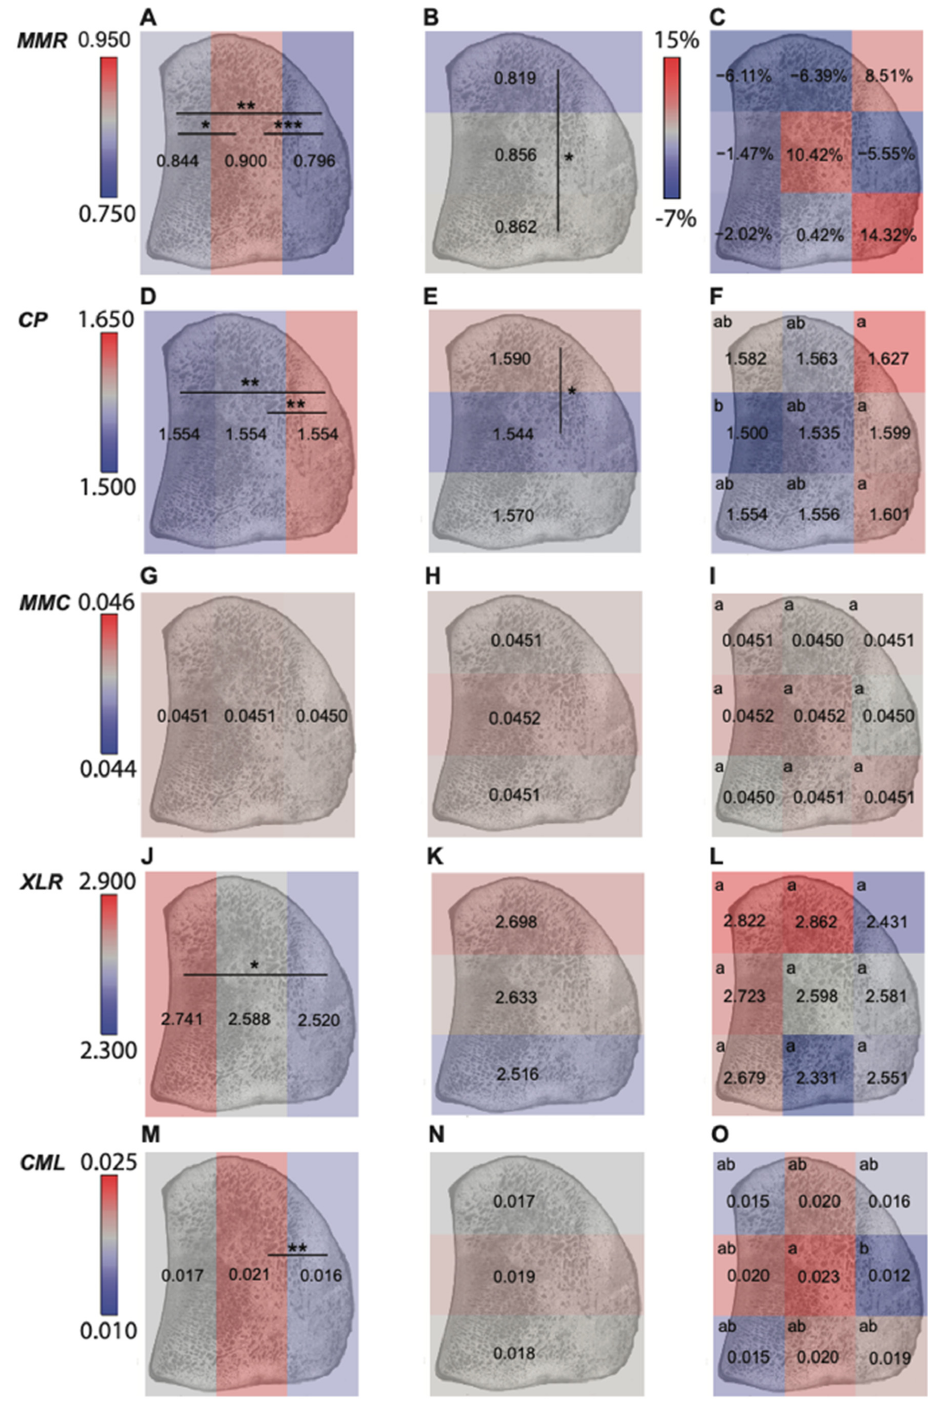
Figure 4. Regional comparison results within a mid-sagittal section of the proximal sesamoid bone of ( A ) mineral:matrix ratio across 3 dorsal-palmar regions; ( B ) mineral:matrix ratio across 3 proximal- distal regions; ( C ) mineral:matrix ratio across 9 anatomic sub-regions; ( D ) carbonate: phosphate ra- tio across 3 dorsal-palmar regions; ( E ) carbonate: phosphate ratio across 3 proximal-distal regions; ( F ) carbonate: phosphate ratio across 9 anatomic sub-regions; ( G ) mineral maturity/crystallinity across 3 dorsal-palmar regions; ( H ) mineral maturity/crystallinity across 3 proximal-distal regions; ( I ) mineral maturity/crystallinity across 9 anatomic sub-regions; ( J ) XLR across 3 dorsal-palmar regions; ( K )